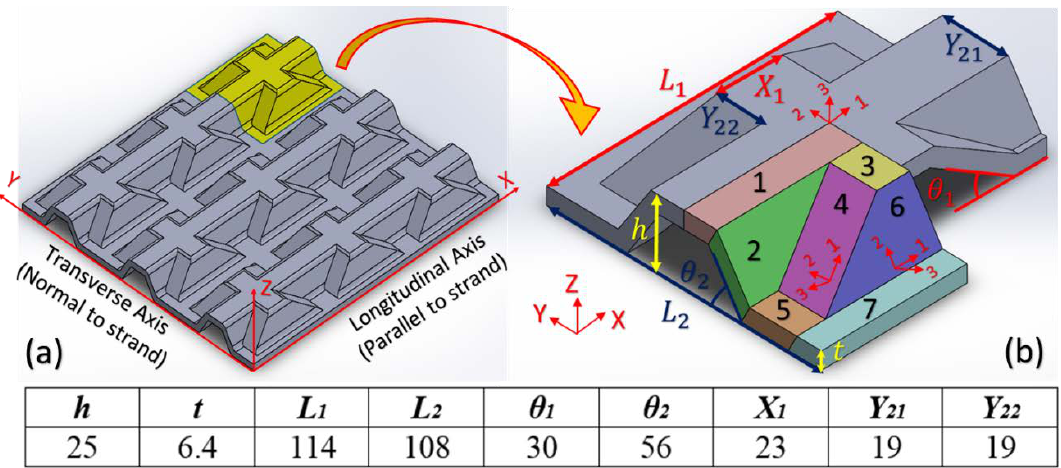
Figure 2. Biaxial corrugated core ( a ) highlighted unit cell ( b ) geometric parameters and their values in mm.